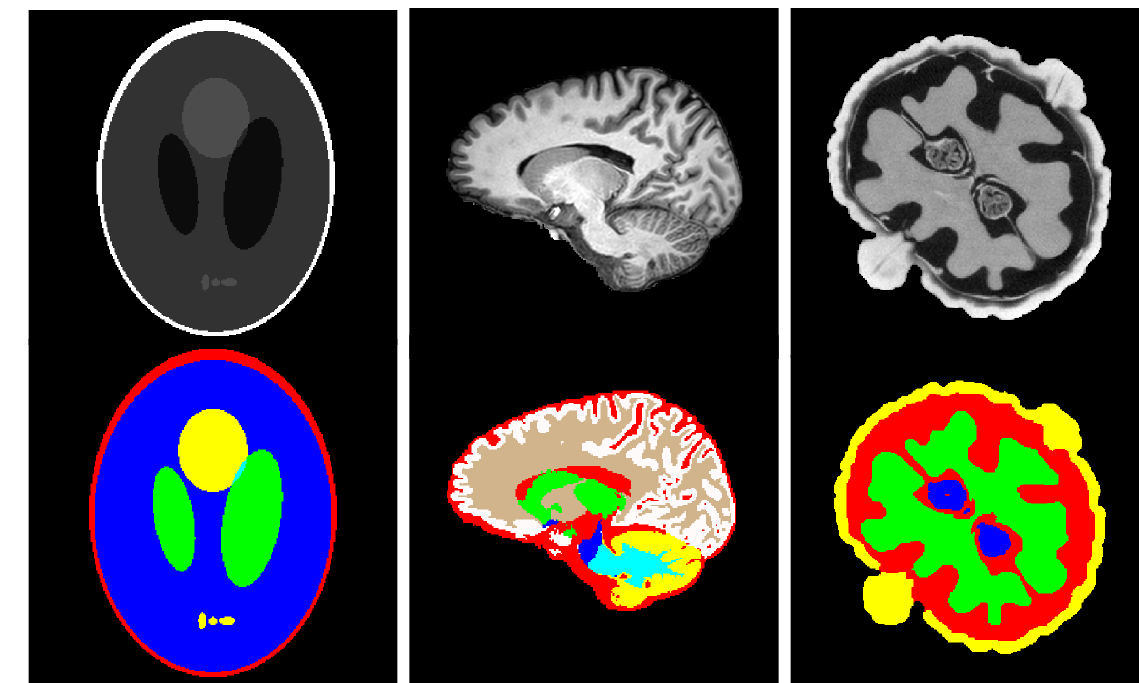
Figure 3. From left to right: a slice of the the SL phantom, Brain MRI and walnut CT. In the second row are the corresponding segmentation images, with a different color used for each different